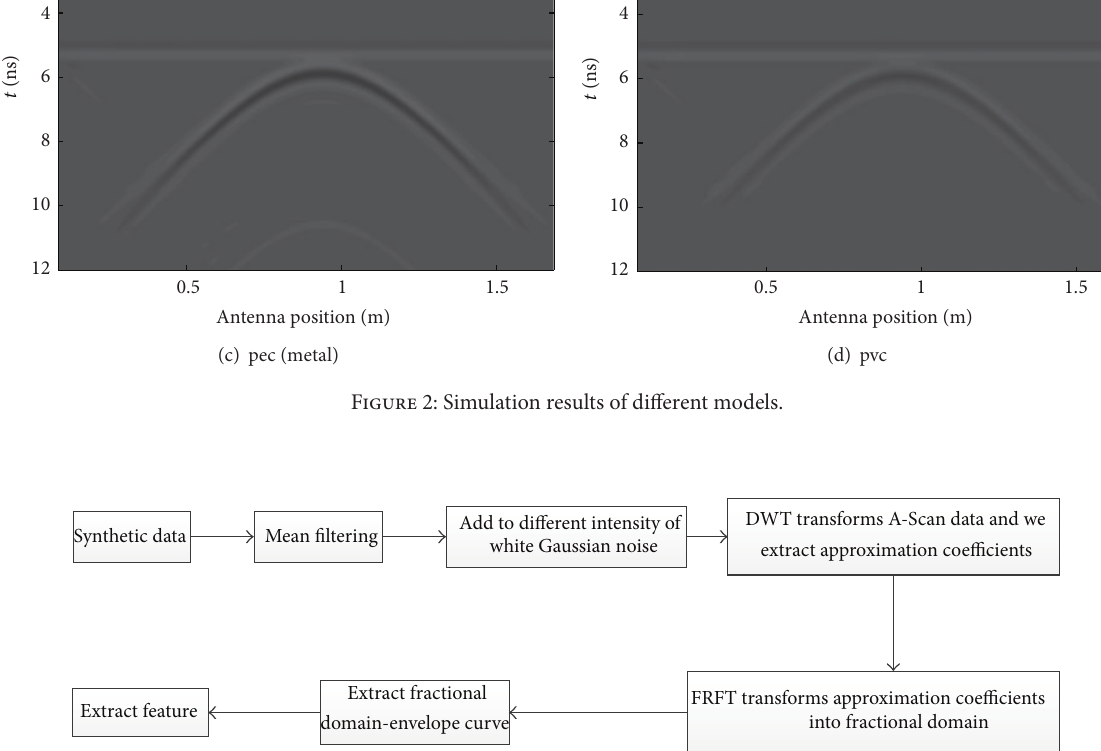
Figure 3: Flow chart of feature